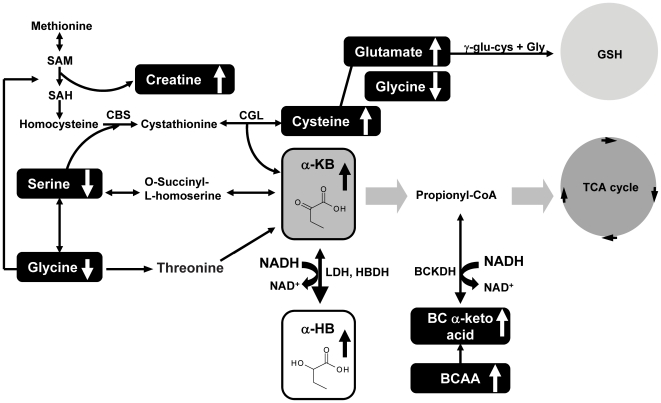
A Model of the biochemical relationship of α-HB biosynthesis and associated metabolic pathways with Insulin Resistance.α-HB is produced from the conversion of α-KB in a reaction catalyzed by LDH that occurs when the NADH/NAD+ ratio is elevated, as can occur from higher lipid oxidation events. Metabolites that change significantly (screening and targeted data, p<0.01) are indicated by a box; arrows indicate the direction of change. α-HB, alpha-hydroxybutyrate; α-KB, alpha-ketobutyrate; BCAA, branched chain amino acids; BCKDH, branched chain alpha keto acid dehydrogenase; CBS, cystathionine-beta-synthase; CGL, cystathionine gamma-lyase; HBDH, α-hydroxybutyrate dehydrogenase; LDH, lactate dehydrogenase; SAH, S-adenosyl-L-homocysteine; SAM, S-adenosyl Methionine. All compounds in boxes were measured using targeted assays, with the exception of α-KB, cysteine and BCAAs.